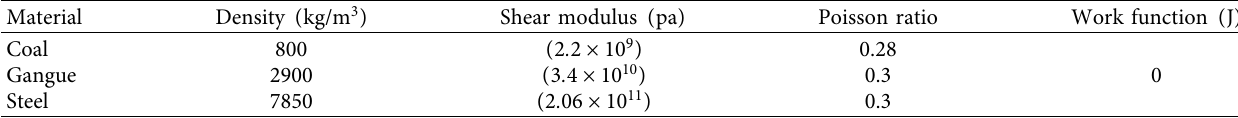
Table 1: Particle material parameters.